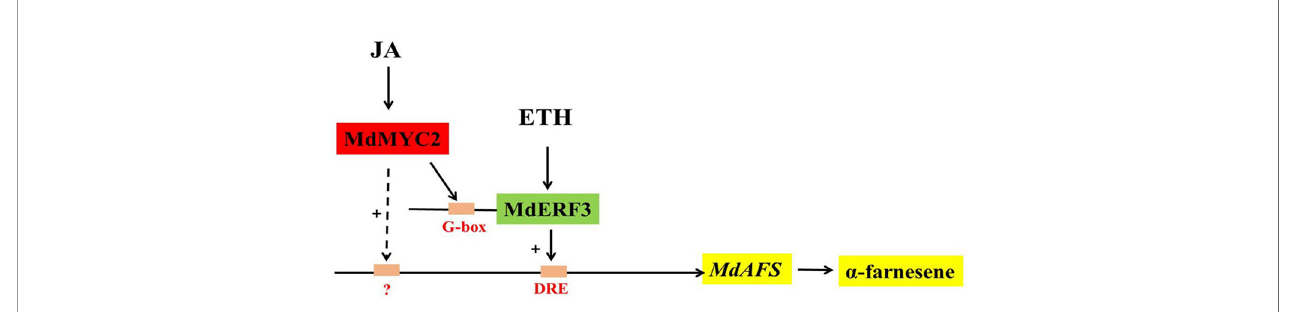
FIGURE 8 | Model of synthesis of a -farnesene regulated by MdMYC2 and